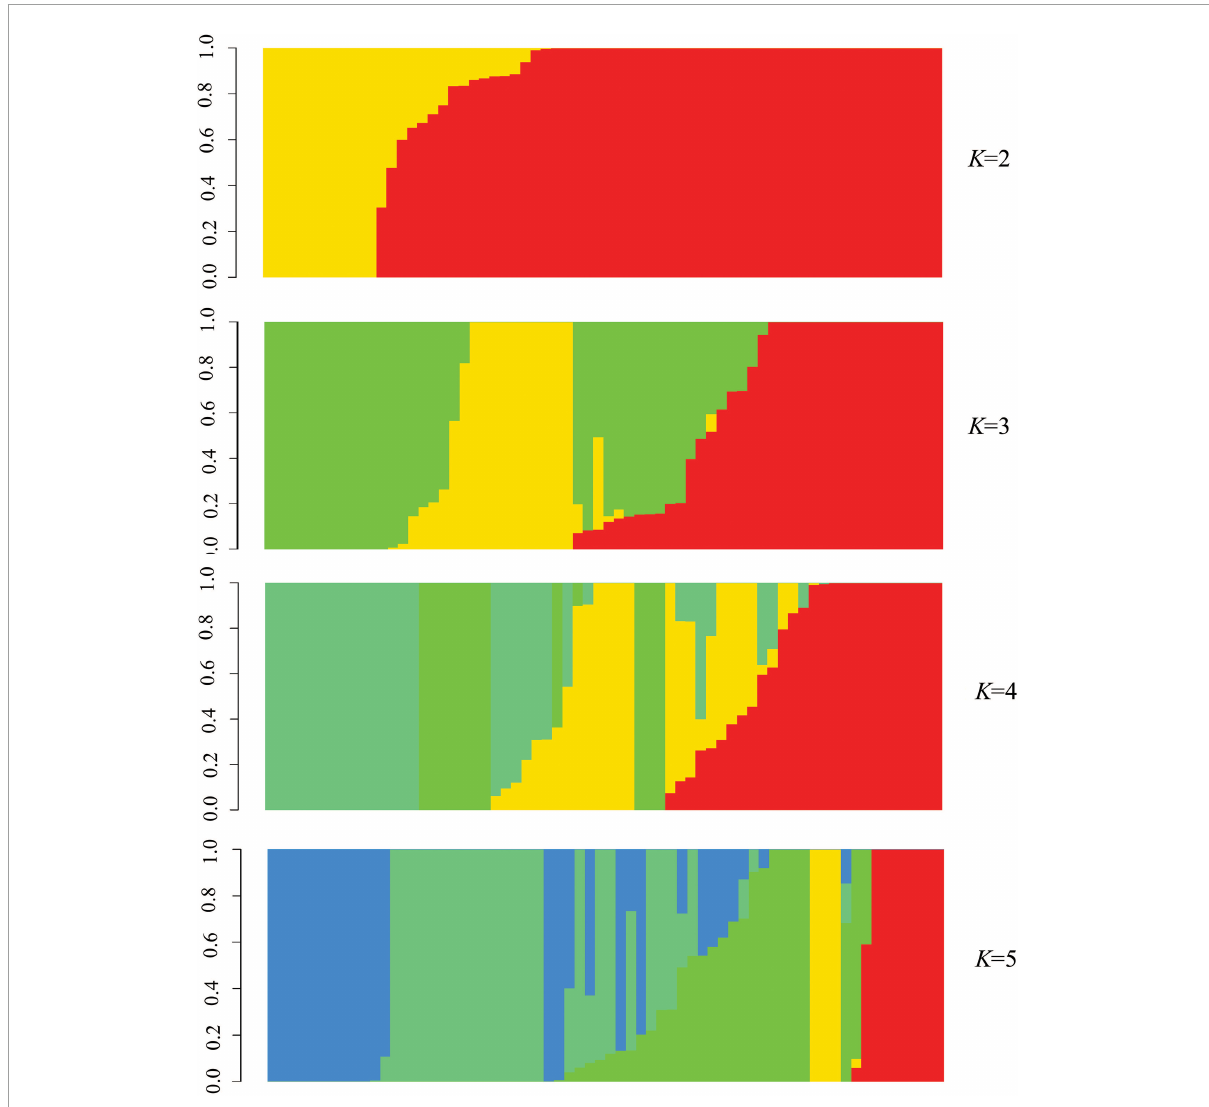
FIGURE3 Population structure of Fusarium proliferatum strains. Each strain was represented by a vertical bar. Each color represented one ancestral population, and the length of each colored segment in vertical bar represented the proportion contributed by ancestral populations.